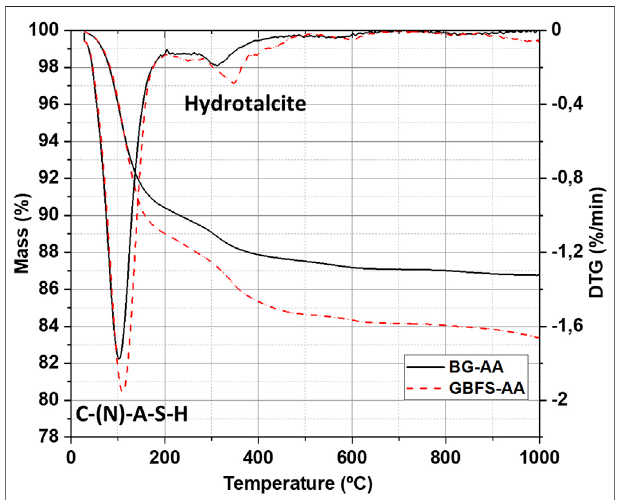
FIGURE 4 | TGA and DTG pro fi les for the prepared alkali activated materials.